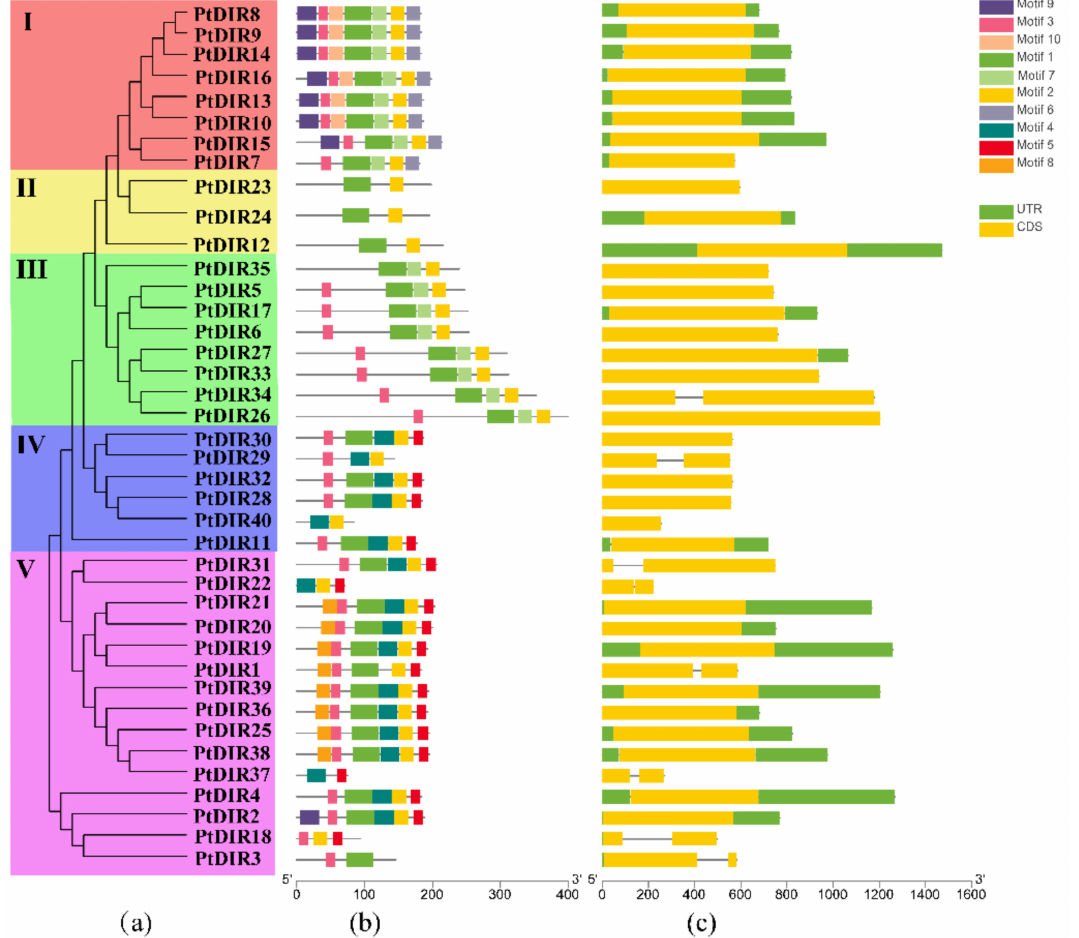
Figure 3. Phylogenetic relationship, conserved motif, and gene structure analyses of PtDIRs. ( a ) Phylogenetic tree of 40 PtDIRs. ( b ) Distribution of conserved motifs in PtDIRs. Ten putative motifs are shown in different colored boxes. ( c ) Exon/intron organization of